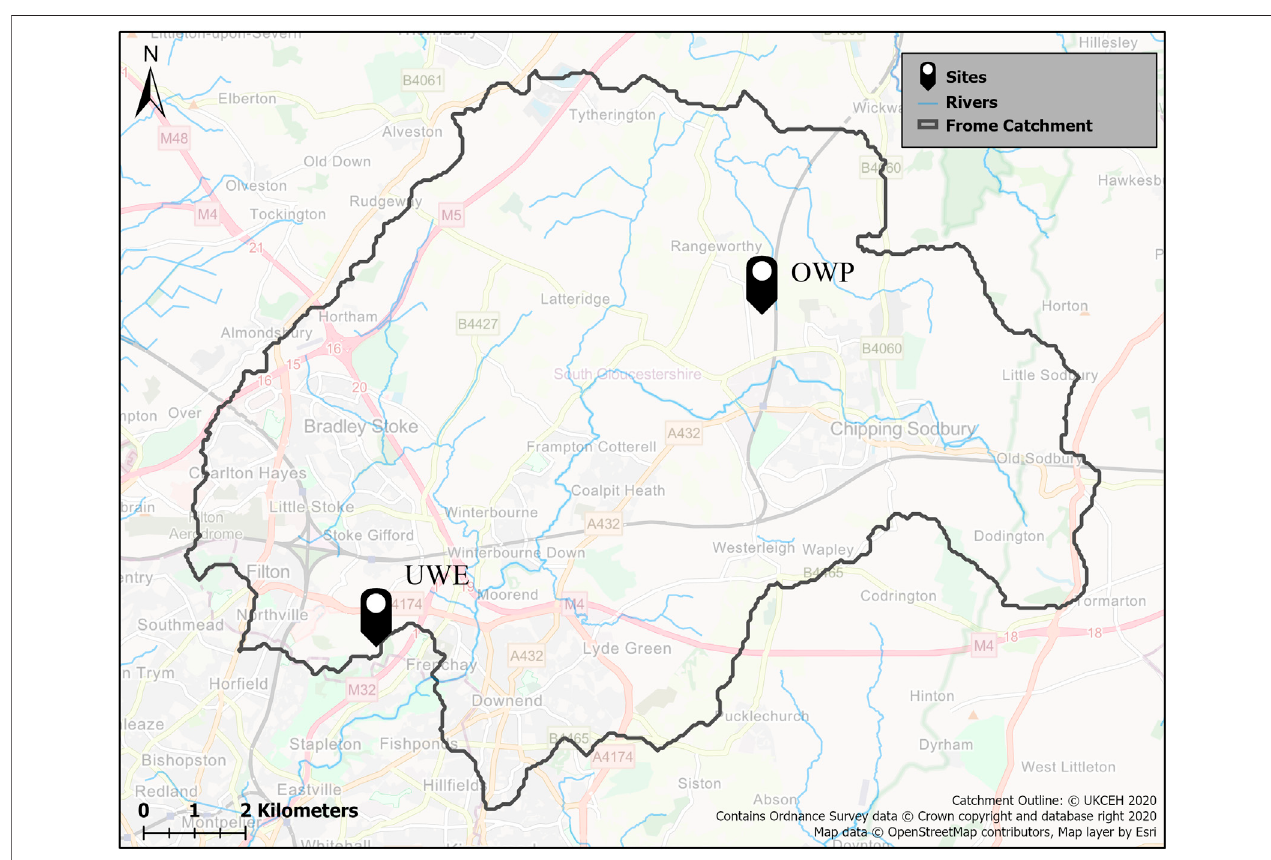
FIGURE 1 | Location of DRY project fi eld sites in the Bristol River Frome Catchment. Image courtesy of H. West (University of the West of England).